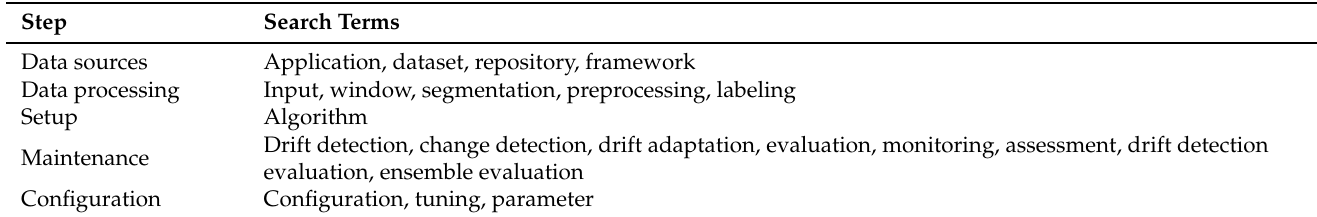
Table 1. Overview over search terms of the structured literature